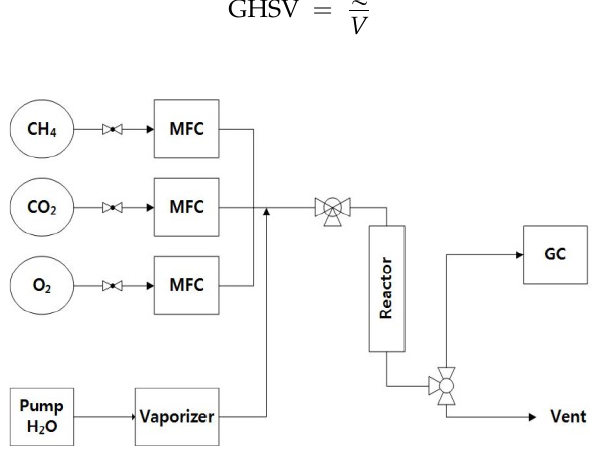
Table 2. Experimental conditions for biogas reforming.